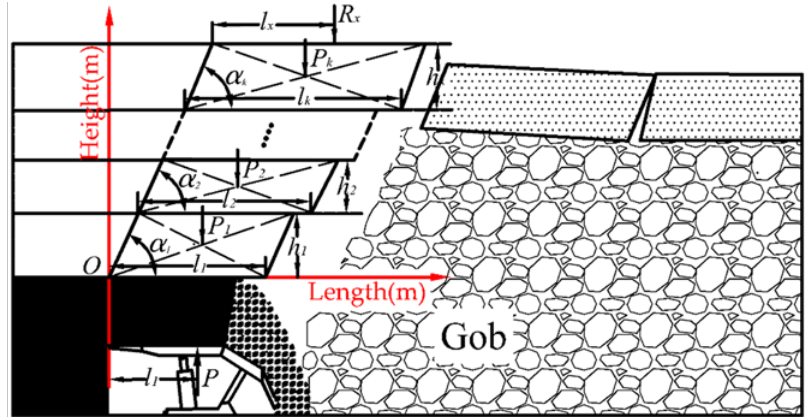
Figure 2. Cantilever beam mechanical model of the immediate roof.